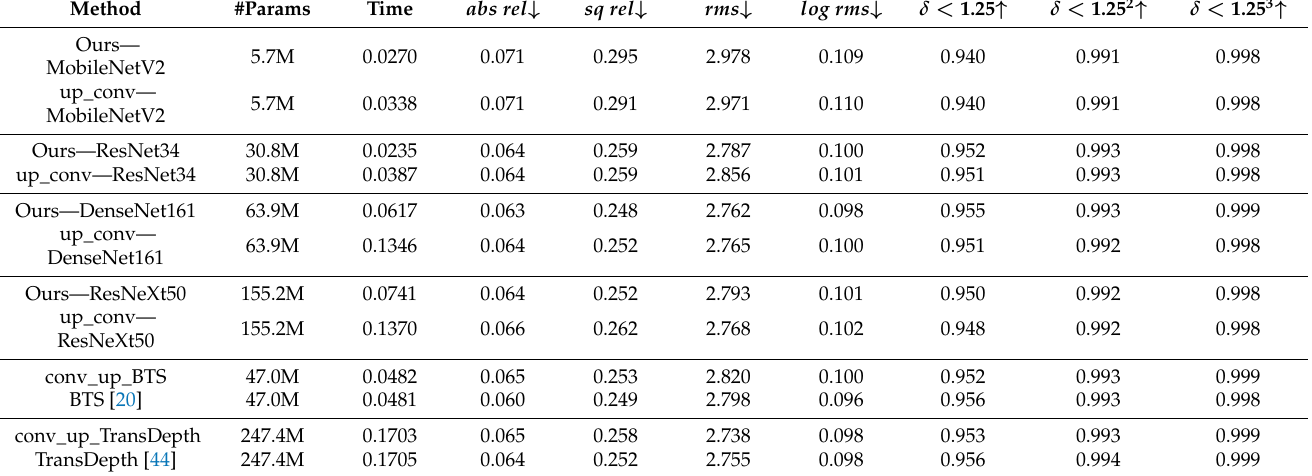
Table 5. Ablation study of two upscale schemes on the KITTI dataset. Four backbones with different amount of parameters are chosen for our proposed decoder. Here, ours and conv_up denote convolution–upsample sequence while up_conv denotes upsample–convolution sequence. The unit of time is second. Restricted by the GPU memory, the batch sizes are set to 4 for experiments up_conv_DenseNet161, conv_up_TransDepth and ResNeXt50 pair. Metrics indicated by ↓ : lower is better; Metrics indicated by ↑ : higher is better.